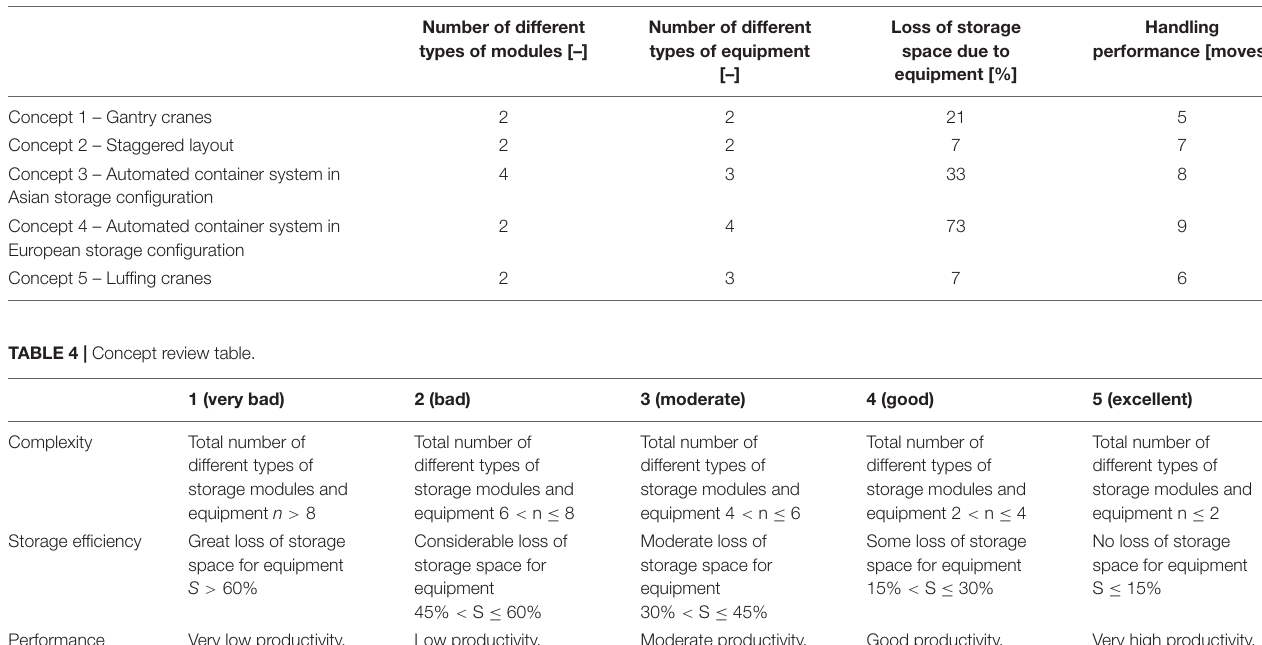
TABLE 3 | Comparison of the five concepts for container handling.